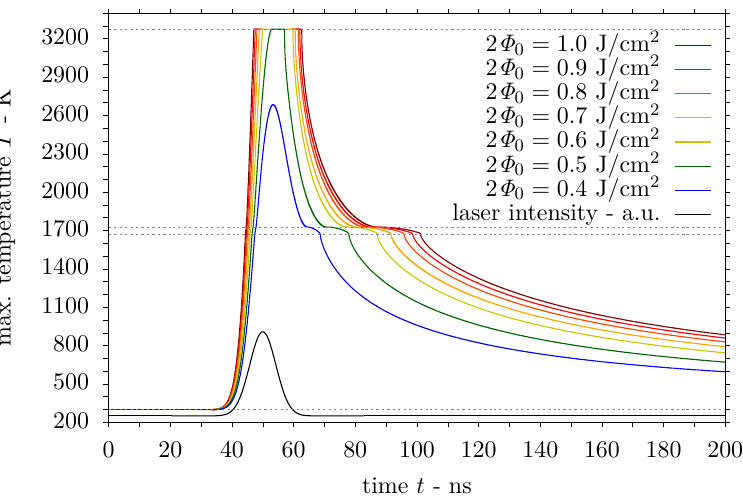
Figure 3. Temporal evolution of surface temperature at interference maximum during single pulse DLIP of AISI 304 stainless steel substrate as predicted by the SPH model for different laser fluences. The variation of the time-dependent laser pulse intensity is indicated for the sake of